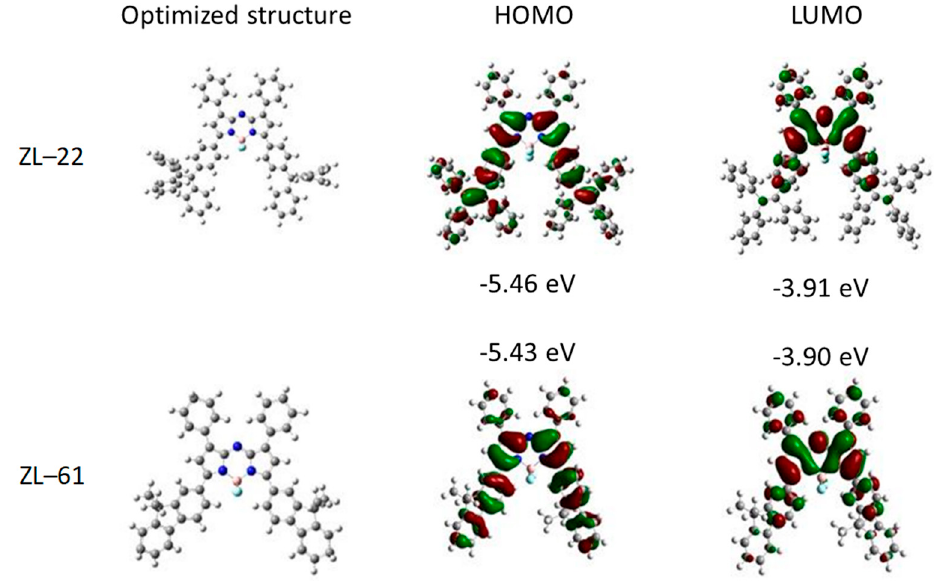
Figure 10. Optimized structures and frontier orbital distributions of ZL-22 and ZL-61 [14].